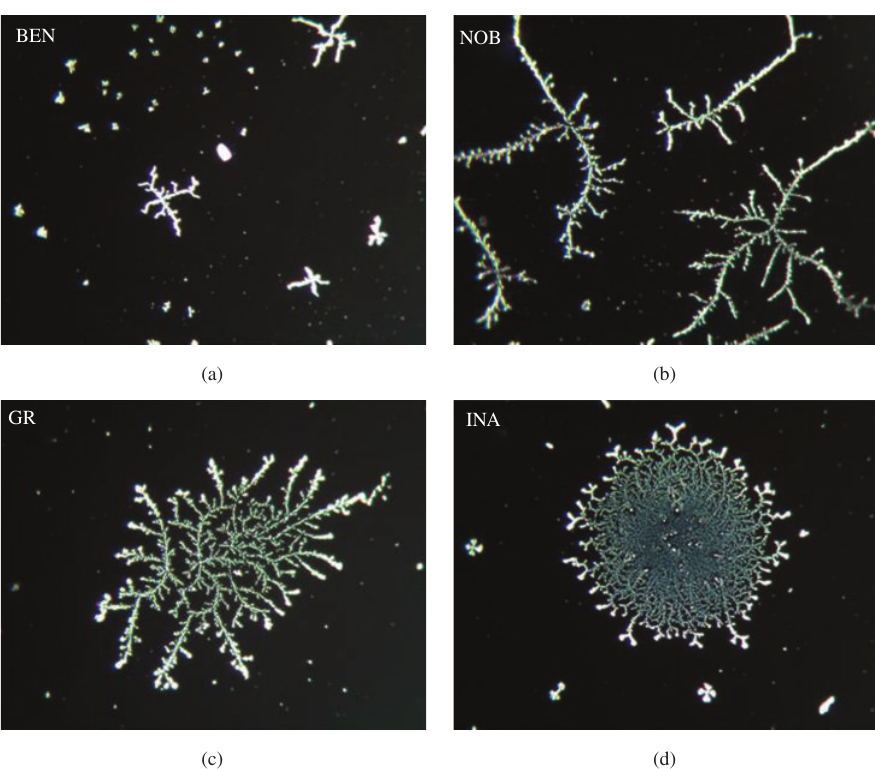
FIGURE 5: Examples of images scored in the visual evaluation by values 3, 4, 6, and 7 for the wheat cultivars Benco (BEN), Nobel (NOB), Gentil Rosso (GR), and Inallettabile (INA), respectively, (magnification 100X).